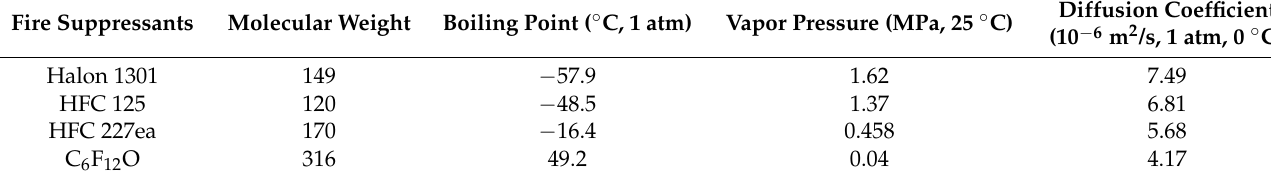
Table 5. Dispersion properties of typical fire suppressants [45].